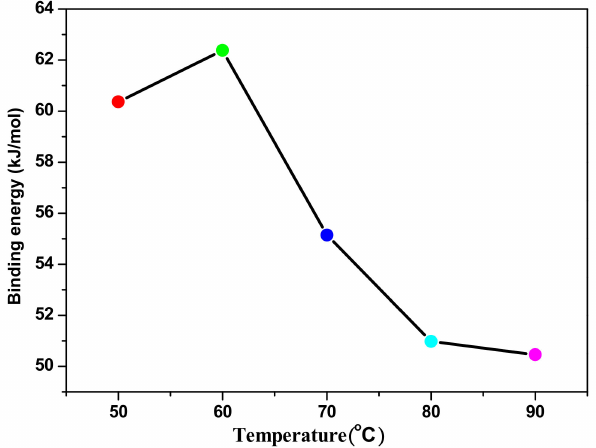
Figure 5. The line chart for MD simulation of the binding energy between UF and RDX under di ff erent temperature